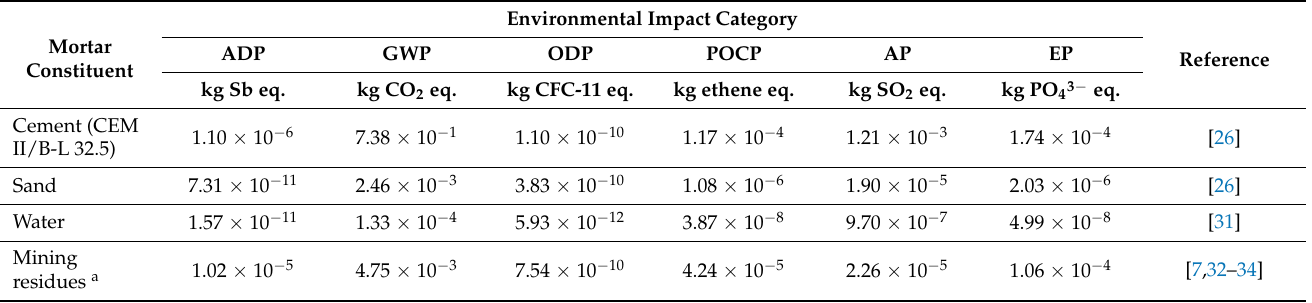
Table 2. Environmental impacts of 1 kg of cement, sand, water, and mining residues.